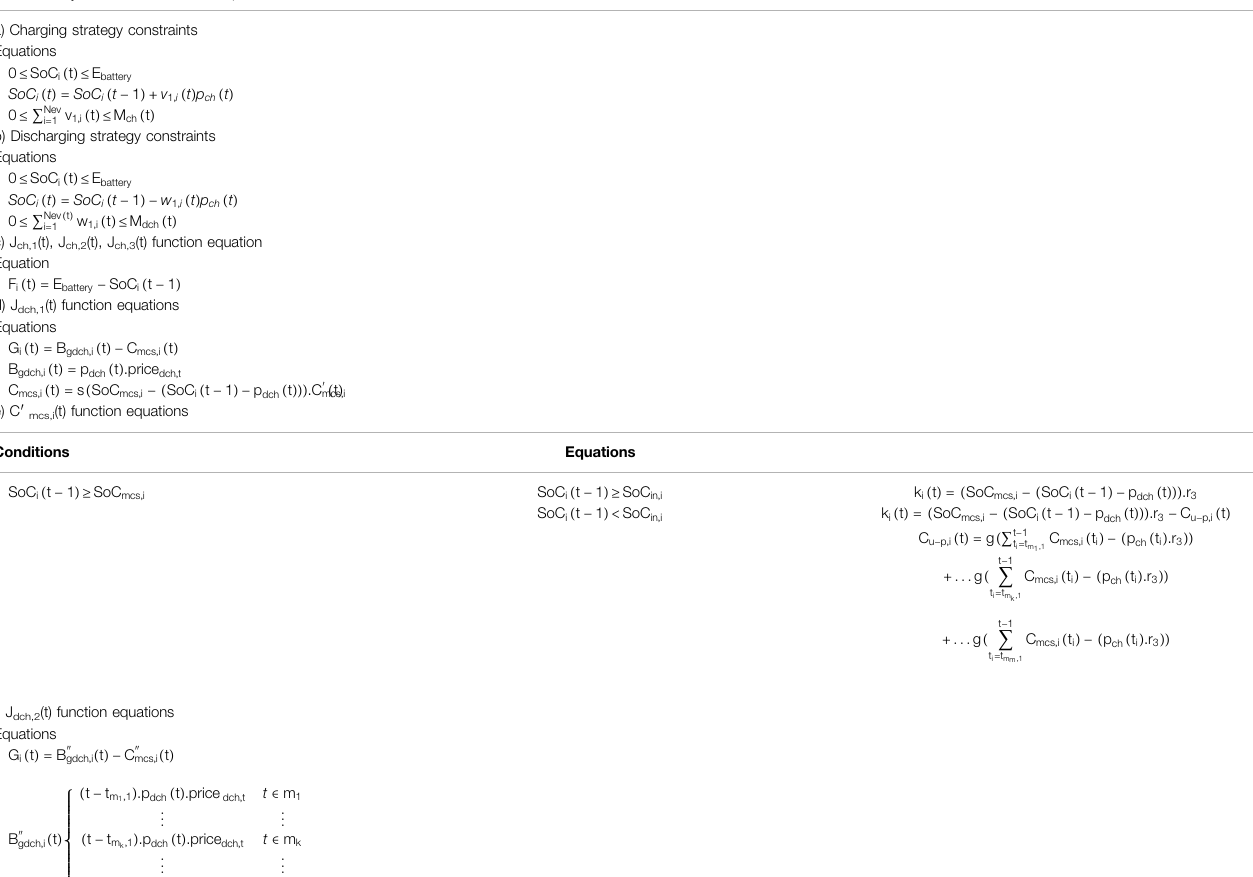
TABLE 1 | Summarization of equations of the functions. a) Charging strategy constraints